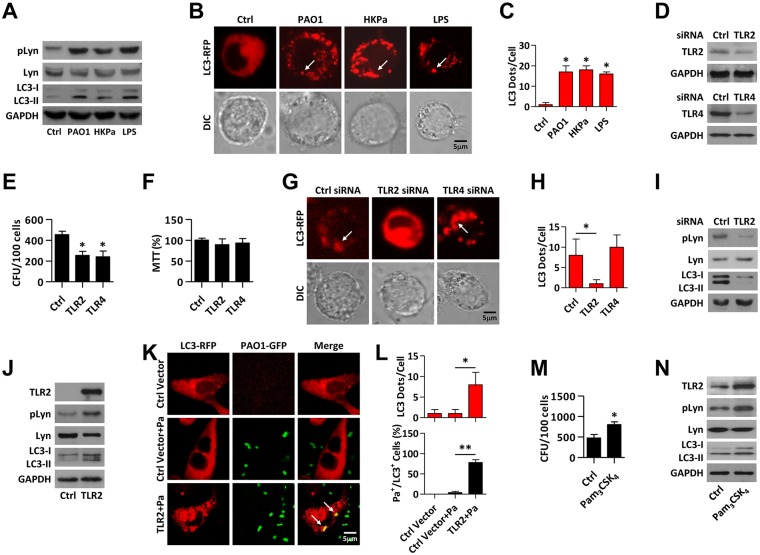
TLR2 is involved in infection-induced autophagy.(A) MH-S cells were infected by PAO1 (MOI = 10), HKPa (MOI = 10) and Pa LPS (100 ng/ml) for 1 h. HKPa was obtained by heating PAO1 at 60°C for 60 min. Cell lysates were collected and immunoblotting of pLyn, Lyn and LC3 were performed. (B, C) MH-S cells were transfected with LC3-RFP plasmid for 24 h. CLSM imaging showed infection by PAO1, HKPa and Pa LPS induced LC3 puncta. LC3 puncta in each cell were counted. Data are derived from 100 cells in each sample. (D) MH-S cells were transfected with Ctrl, TLR2 or TLR4 siRNA for 24 h, respectively. Immunoblotting were performed to prove the knock down of TLR2 or TLR4. (E, F) After TLR2 or TLR4 knock down as above, the cells were infected with PAO1 (MOI = 10, 1 h). MTT assays were used to measure the cell viability and CFU assays were used to measure phagocytosis. (G, H) MH-S cells were co-transfected with LC3-RFP and Ctrl, TLR2 or TLR4 siRNA for 24 h, respectively. Cells were then infected with PAO1 as above. CLSM imaging showed infection-induced LC3 puncta. LC3 puncta in each cell were counted. Data are derived from 100 cells in each sample. (I) MH-S cells were transfected with Ctrl or TLR2 siRNA for 24 h, respectively. Cells were infected with PAO1 as above. Cell lysates were performed for immunoblotting to detect pLyn, Lyn and LC3. (J) The HEK293 cells were stably transfected with a pUNO-TLR2 plasmid which expresses TLR2. TLR2 stable expression cells and 293/null cells were infected with PAO1 as above. Immunoblotting was performed to detect TLR2, pLyn, Lyn and LC3. (K, L) 293 cells were transiently transfected with LC3-RFP. After 24 hours cells were infected with PAO1-GFP (MOI = 10, 1 h). Arrows indicate significant LC3 puncta upon Pa infection using CLSM imaging. LC3 puncta in each cell were counted and the percentage of LC3+/Pa+ events (cell with colocalized puncta of LC3-RFP and PAO1-GFP) is shown. Data are derived from 100 cells in each sample. (M, N) MH-S cells were pretreated with Pam3CSK4 (300 ng/ml), and infected with PAO1 as above. Cells were homogenized for CFU and immunoblotting to detect TLR2, pLyn, Lyn and LC3. All data are representative as means+SD of three independent experiments. One-way ANOVA (Tukey’s post hoc); *, p<0.05; **, p<0.01. Scale bar = 5 μm.